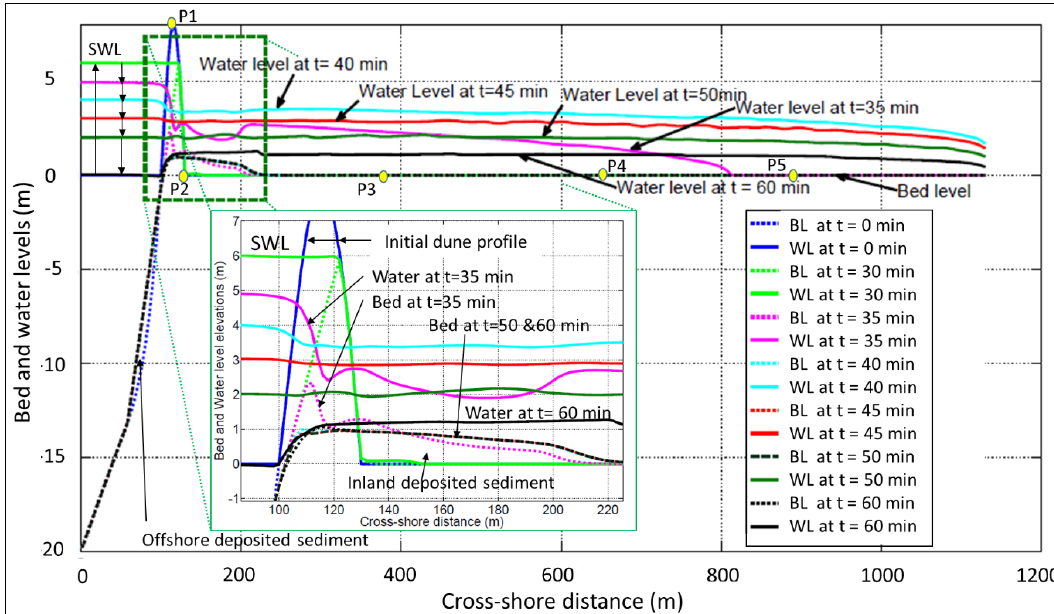
Figure 6 . Evolution of the bed level (BL) and water level (WL) for the synthetic profile in Figure 1a under load case 2 (LC2) as defined in Figure